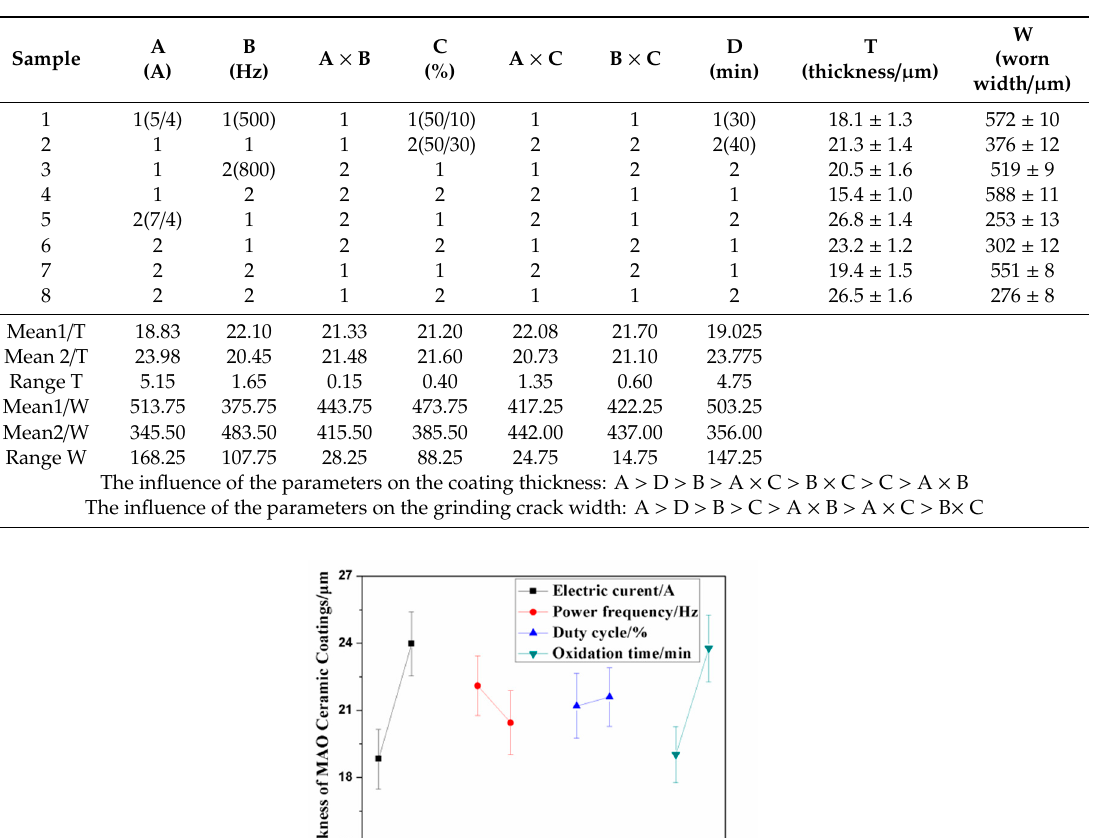
Table 2. Experimental results and range analysis of the orthogonal test.